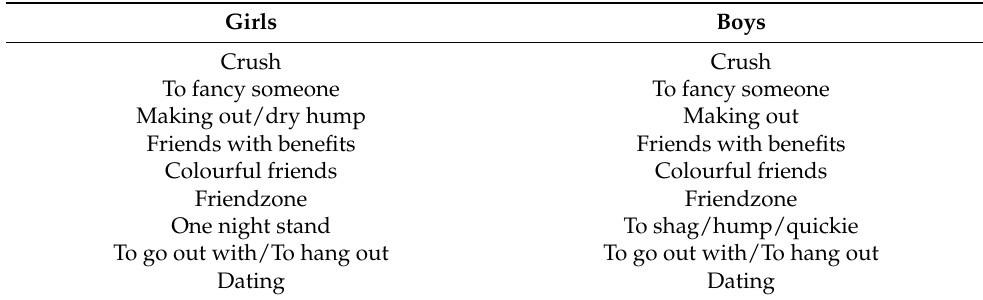
Table 3. Terms attributed by adolescents (boys and girls) to intimate relationships. Girls Boys Crush Crush To fancy someone To fancy someone Making out/dry hump Making out Friends with benefits Friends with benefits Colourful